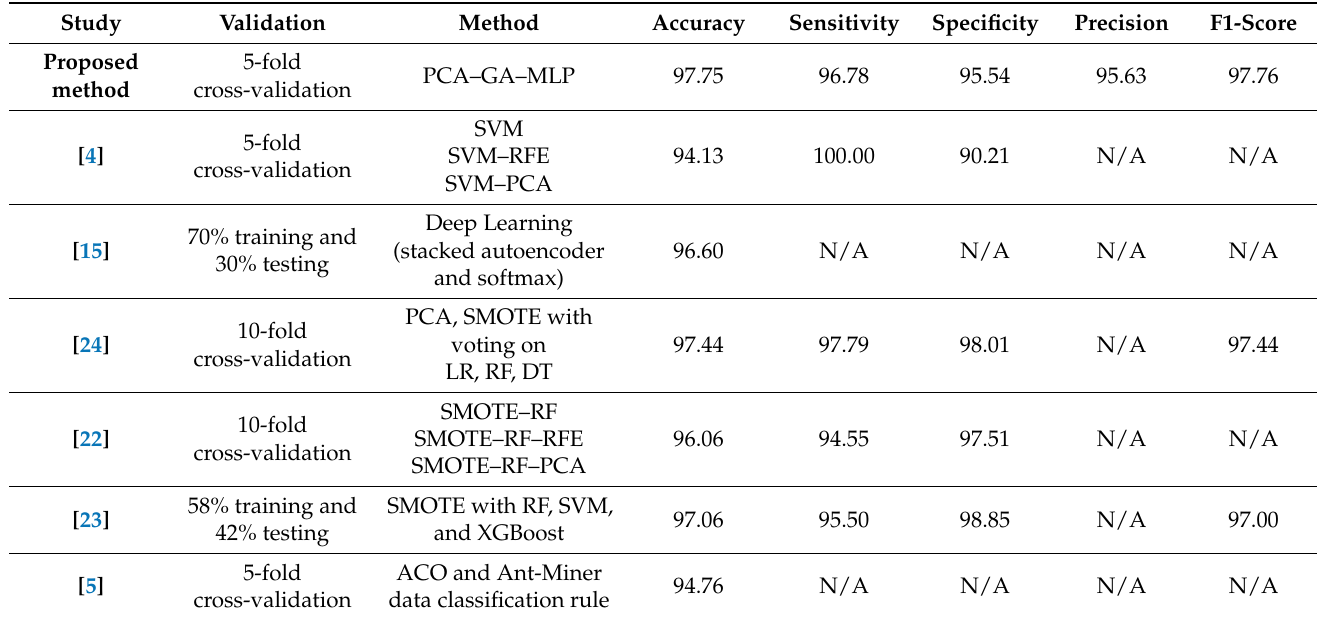
Table 12. Comparison of the proposed method with the best results in the literature in diagnosing Biopsy.